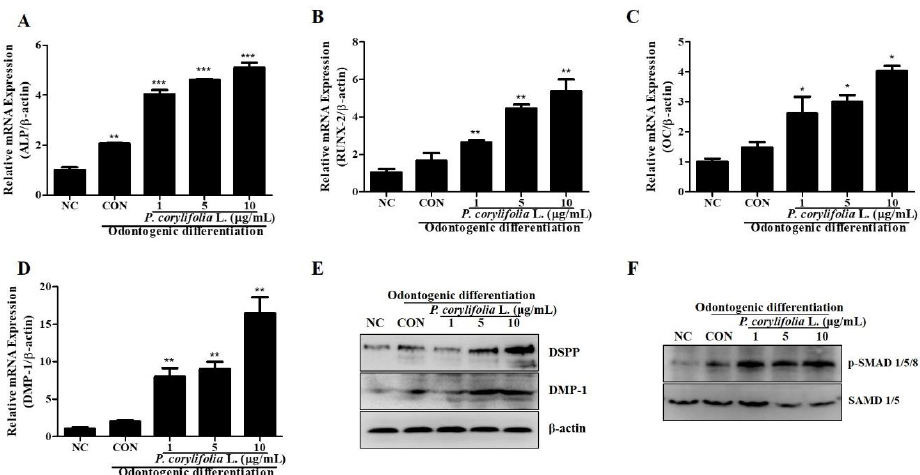
Figure 2. Real-time PCR and western blot analysis during odontogenic differentiation in hDPSCs. ( A – D ) Odontogenic differentiation marker gene (APL, RUNX-2, OC, and DMP-1) expression in hDPSCs treated with 1, 5, and 10 μg/mL of P. corylifolia extracts. ( E ) Western blot analysis for the expression of odontogenic differentiation protein markers DMP-1 and DSPP expression. ( F ) Western blot analysis to determine the effect of P. corylifolia extracts on SMAD 1/5/8 phosphorylation. All data are presented as the mean ± SEM (n = 3). * p < 0.05, ** p < 0.02, *** p < 0.01. SEM, standard error of mean; NC, negative control; CON, positive control; hDPSCs, human dental pulp stem cells; PCR, polymerase chain reaction.